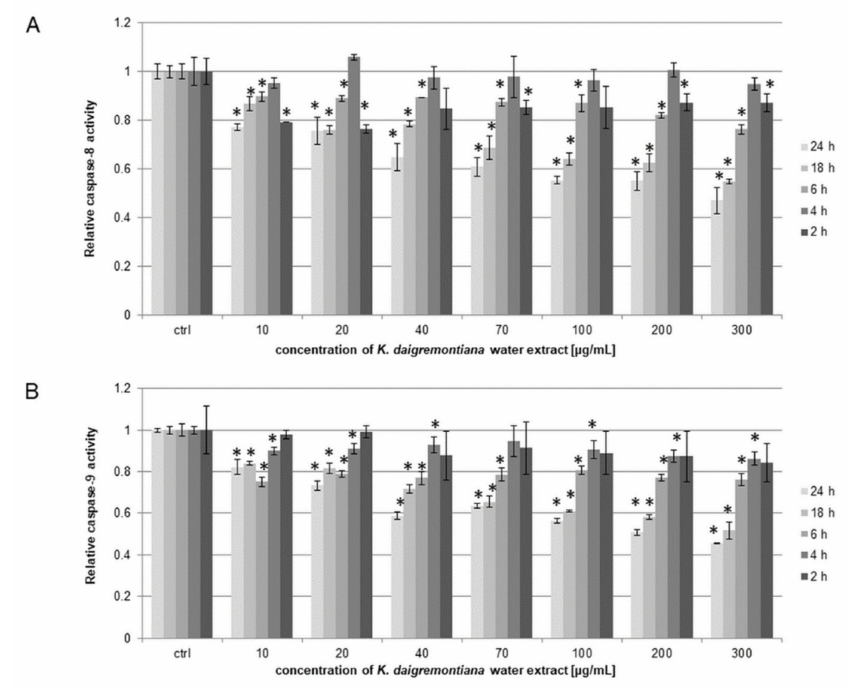
Figure 4. Relative activity levels of caspases-8 ( A ) and 9 ( B ) in SKOV-3 cells treated with K. daigremon- tiana water extract for 2–24 h and estimated with luminometry. The values represent the means ± SD of three independent experiments. Error bars represent standard deviations. Significant differences relative to the control are marked with an asterisk “*” (Student’s t -test, p <